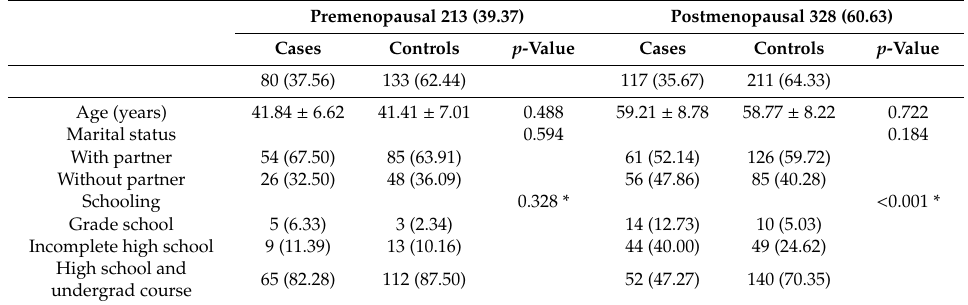
Table 1. Demographic and economic characteristics among participants according to menopausal status.